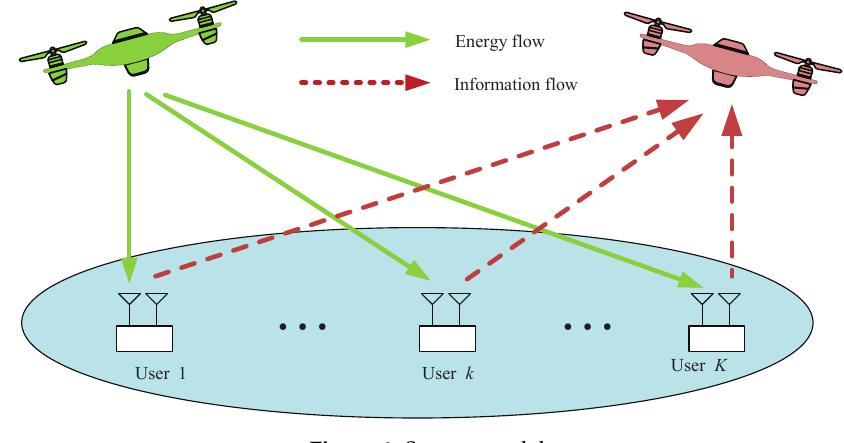
Figure 1. System